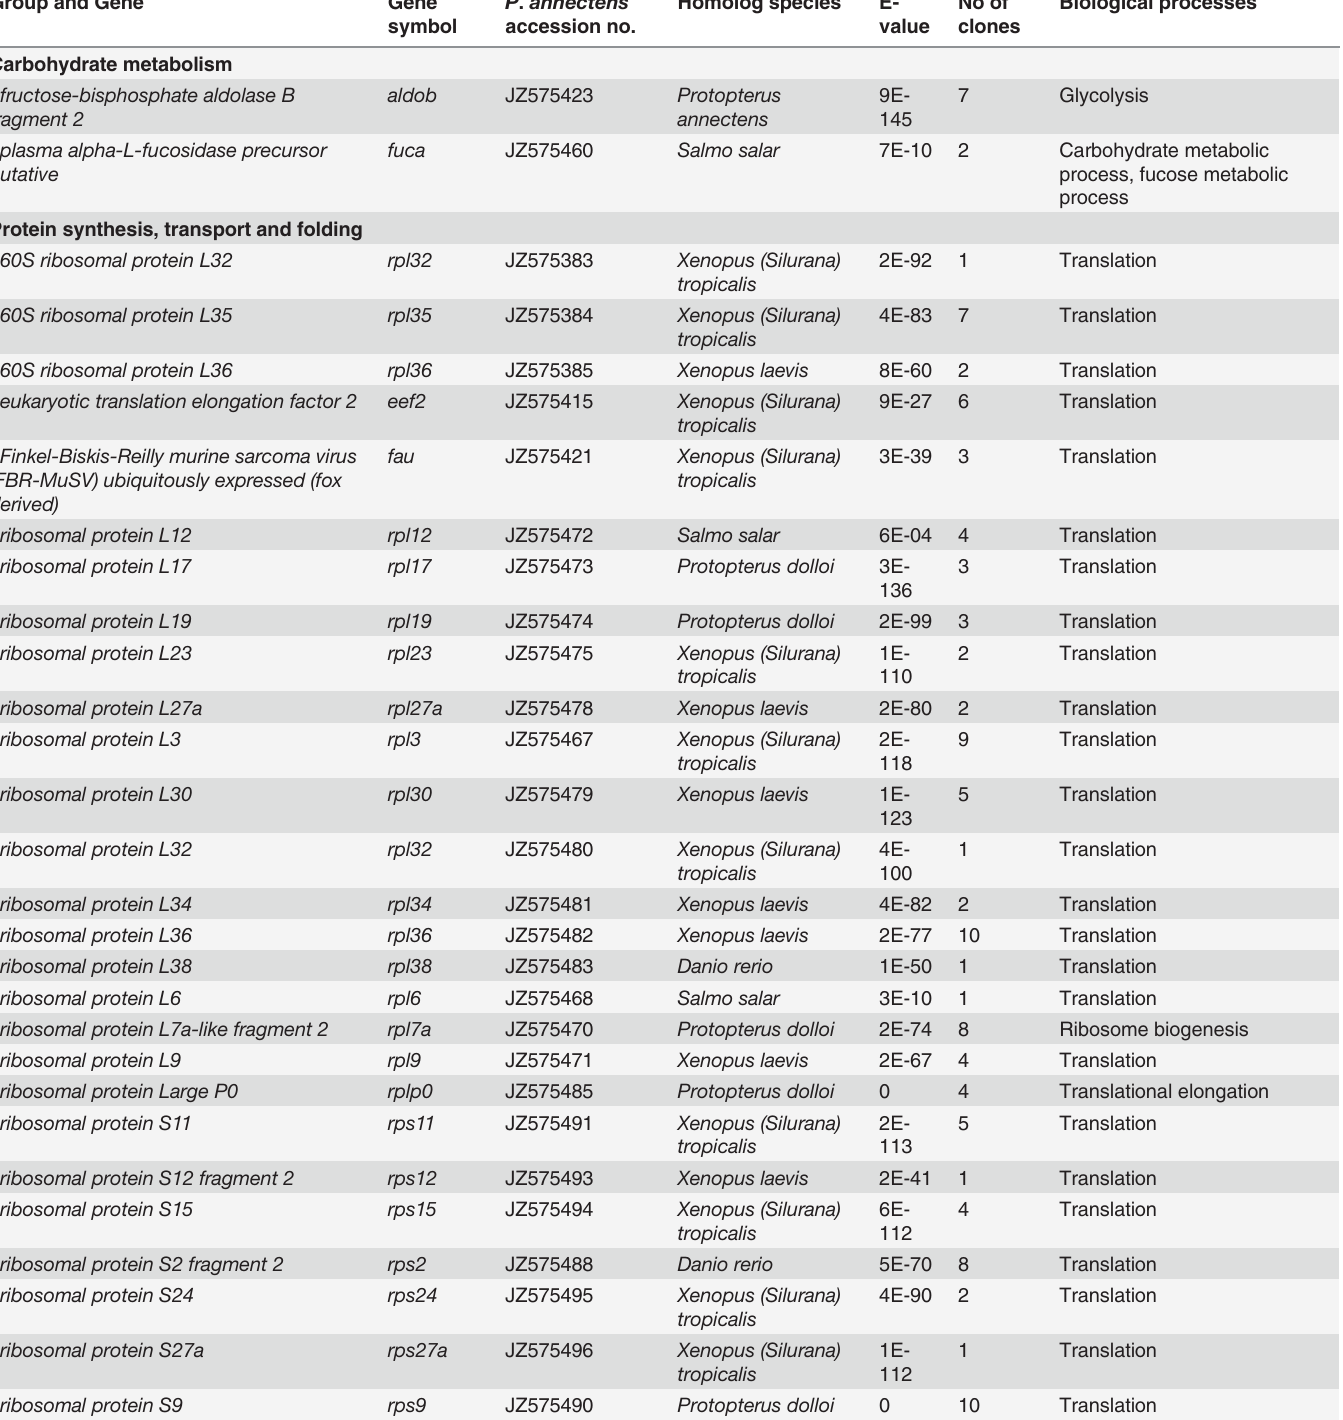
Table 5. Known transcripts found in the reverse SSH library (down-regulation) obtained by suppression subtractive hybridization PCR from the liver of Protopterus annectens after 1 day of arousal from 6 months of aestivation with fi sh aestivated for 6 months in air as the reference for